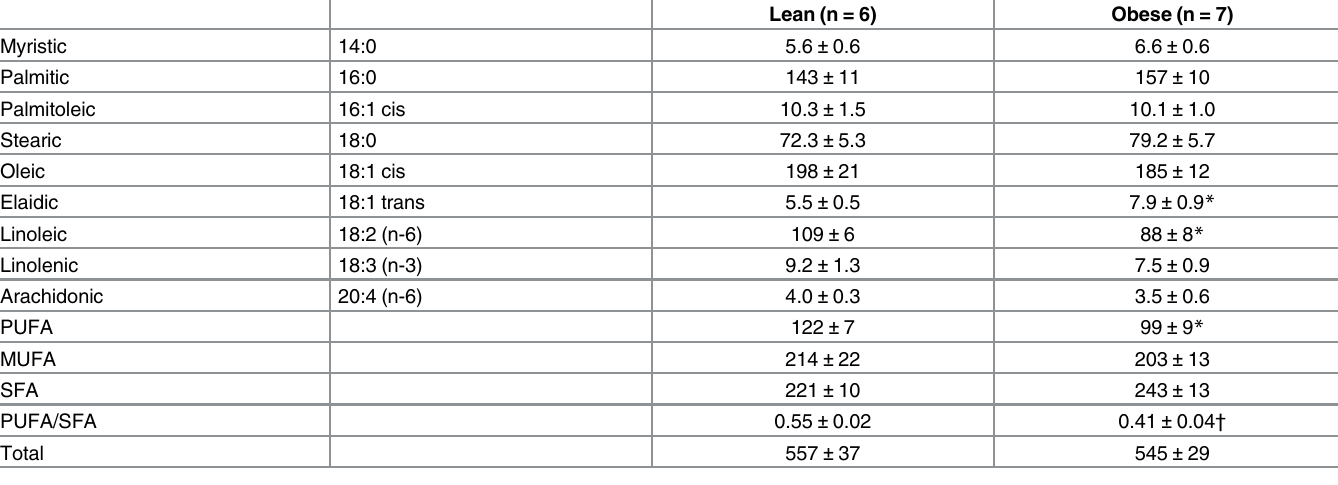
Table 3. Circulating non-esterified fatty acids